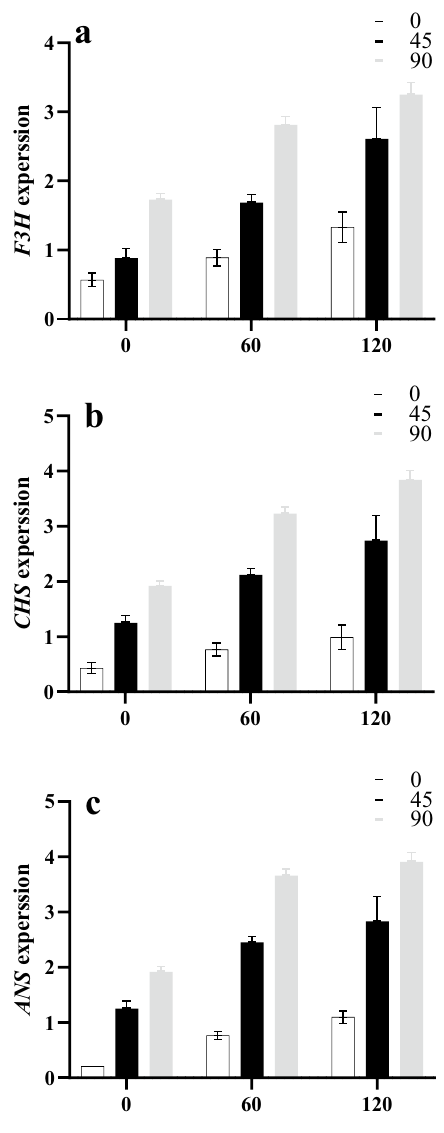
Figure 7. Interactions effects of salinity and NPs on expression of F3H , CHS , and ANS genes in